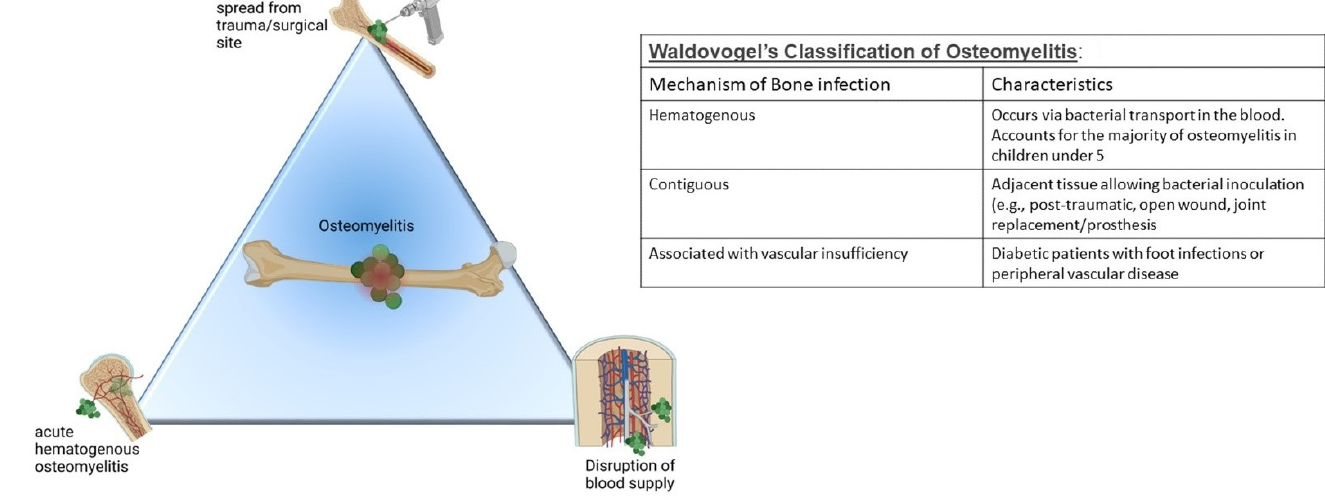
Figure 1. Osteomyelitis arises in one of three primary ways. Regardless of the underlying cause, vascular disruption due to the formation of sequestra can occur, making treatment very difficult (Lima et al.). Waldvogel’s classification of osteomyelitis [3] describes the characteristics of each of these ways. Figure created with